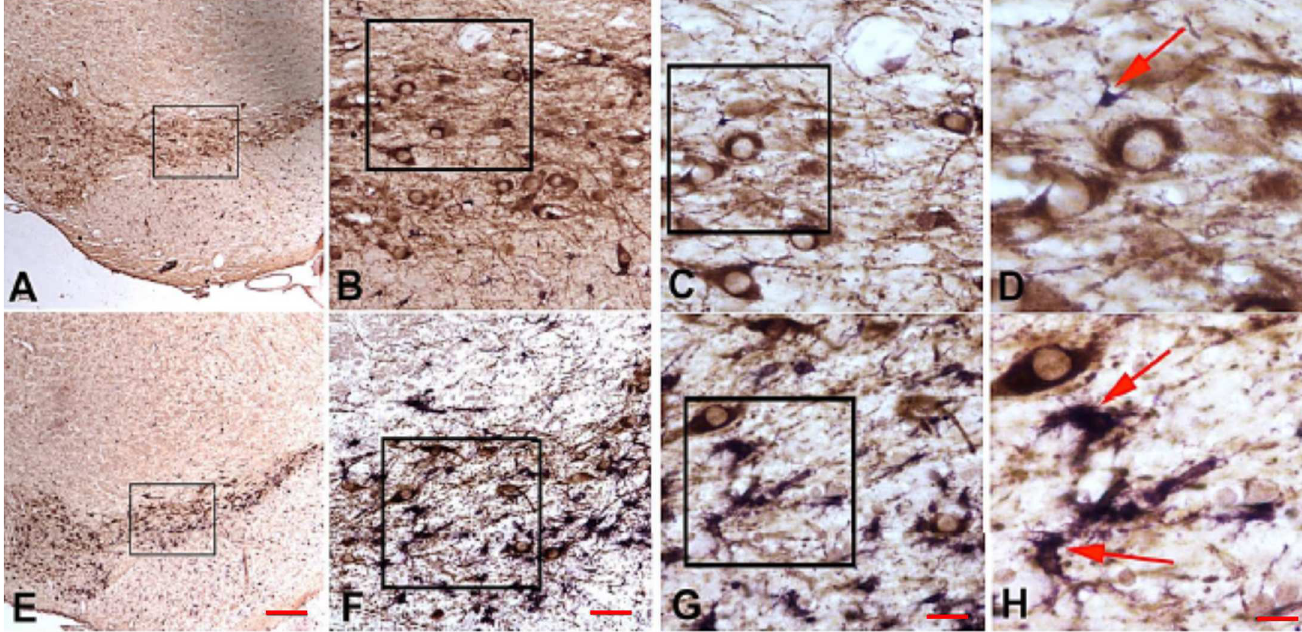
Fig 3. Appearance of microglia in PQ- and MPTP-treated mice. Representative photomicrographs of microglia(Iba-1+) cells in PQ-treated (Panels A-D) or MPTP-treated (Panel E-H) in the SNpc of C57BL/6J or C57BL/6NHsd male mice aged 9- or 16-weeksat the time of the 1 st dose. The boxes in each panel indicate the region shown in the adjacent box. Red arrow in D shows an example of resting microglia; characterized by a small cell body and thin processes. Red arrows in H show the typical appearanceof activated microglia seen in MPTP-treated mice where the cell body is increasedin size comparedto resting microglia and the processes are shortened and thickened. Scale bars A,E = 100 μ m, B,F = 40 μ m, C,G = 20 μ m, D-H = 10 μ m.